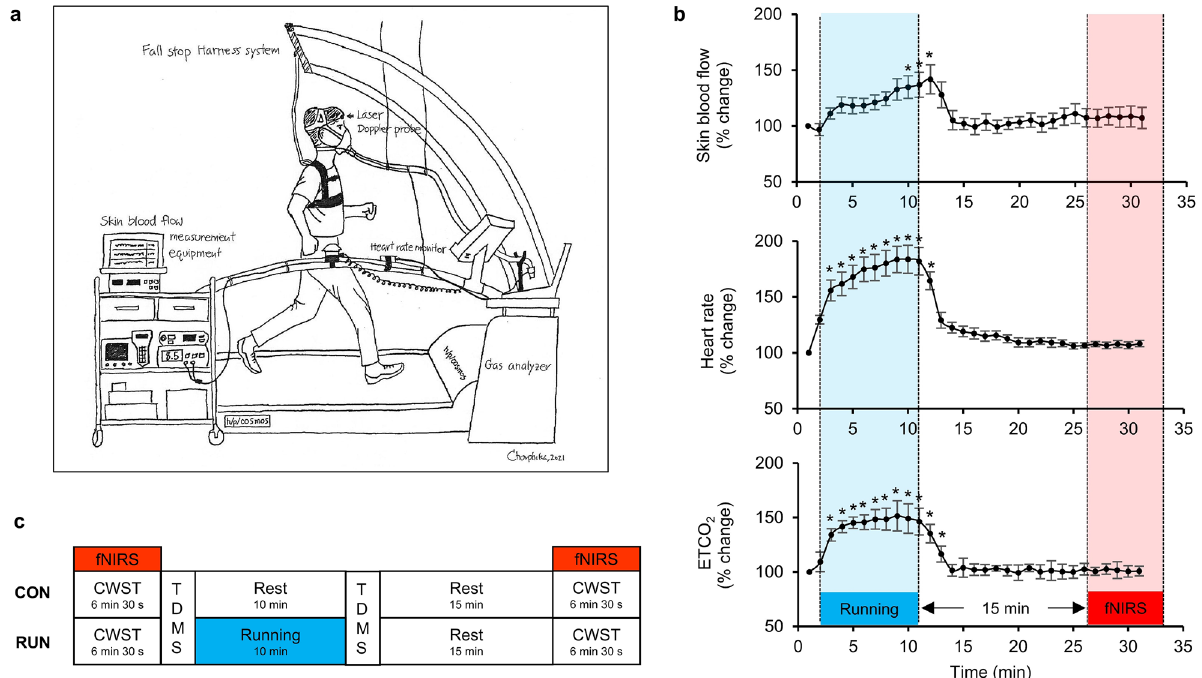
Figure 6. ( a ) Illustration of experimental setup for the second preliminary step: non-cortical physiological measurements. A laser Doppler probe was attached to the forehead to assess skin blood flow. ( b ) Results of non- cortical physiological parameters at baseline (set at 100%), during 10 min of moderate-intensity running and 20 min rest. Time points with a significant change compared to baseline are identified with asterisks ( p < 0.05, one-way ANOVA with Dunnett correction). All physiological variables fully returned to baseline within 15 min. Thus, fNIRS measurement was started 15 min after running to eliminate possible signal contamination. ETCO 2 = End-tidal carbon dioxide; ( c ) Experimental design for control (CON) and running (RUN) sessions. CWST = color-word matching Stroop task, TDMS = Two-Dimensional Mood Scale, fNIRS = Functional near- infrared